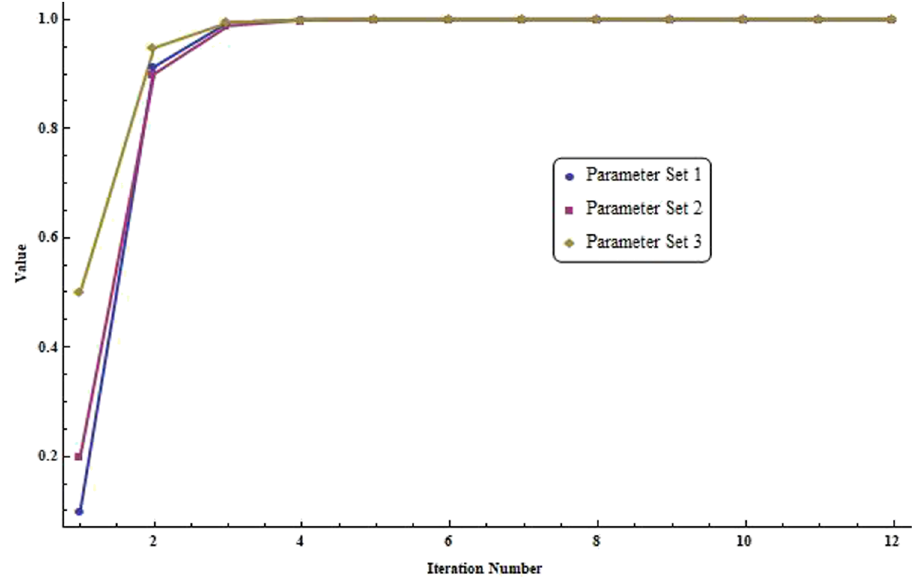
Figure 3: Graph corresponding to Table